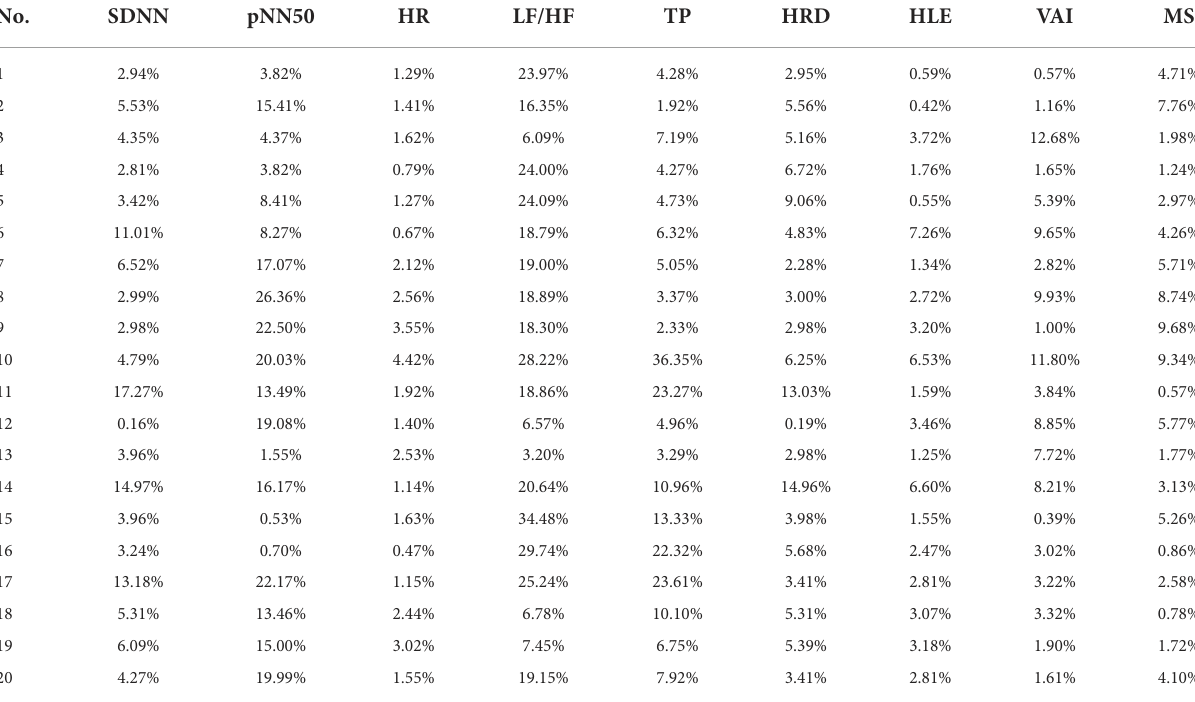
TABLE 5 Error rate of HRV